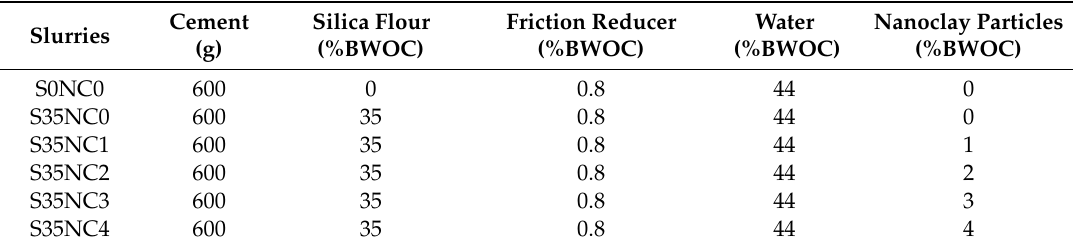
Table 2. Cement slurries compositions.